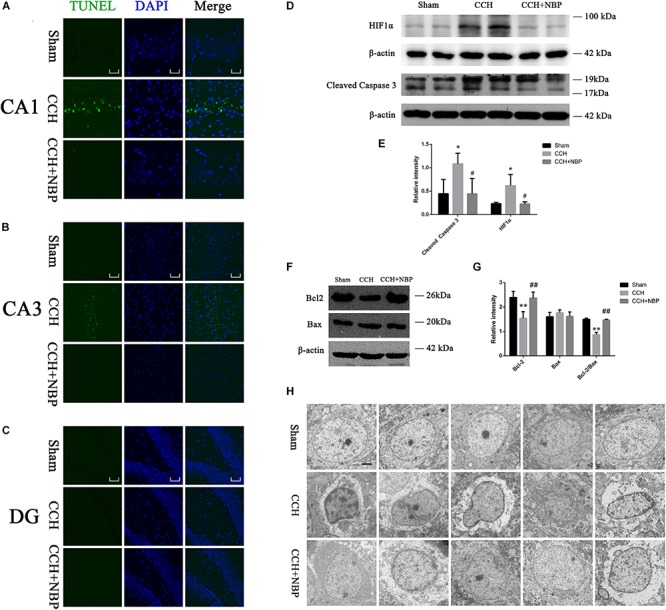
Dl-3-n-butylphthalide improved hippocampal neuronal apoptosis in the CCH model. TUNEL staining (green) shows neuronal apoptosis in the hippocampus (CA1(A), CA3(B), and DG(C) areas) of sham, CCH, and CCH + NBP groups at 8 weeks after BCCAO. Nuclei were stained with DAPI (blue). CA1 area, 400× magnification, scale bar = 25 μm. CA3 and DG areas, 200× magnification, scale bar = 50 μm. (D) Western blot analysis of the expression of HIF-1α and cleaved caspase-3 in vivo. (E) The expression of HIF-1α and cleaved caspase-3 were quantified and represented as a histogram. β-actin was used as an internal control. n = 3 experiments. *P < 0.05, CCH group vs. sham group; #P < 0.05, CCH vs. CCH + NBP group. (F) Bcl-2 family proteins are involved in the anti-apoptotic effect of NBP. (G) The expression of Bcl-2, Bax and Bcl-2/Bax ratio were quantified and represented as a histogram. β-actin was used as an internal control. n = 3 experiments. ∗∗P < 0.01, CCH group vs. sham group; ##P < 0.01, CCH vs. CCH + NBP group. (H) NBP treatment protects against morphological and ultrastructural changes of neurons in the hippocampus. Sham group: the neurons in the cortex had large round nuclei, the double nuclear membranes were clear and complete. CCH group: neurons were irregular and exhibited chromatin condensation, cytoplasm dissolution, and vacuole formation. The nuclear membranes and organelles of neurons were dissolved or absent. NBP treatment group: the damage to the neurons was alleviated (n = 5 per group). Scale bar = 2 μm. CCH: CCH 8w; CCH + NBP: CCH 8w + NBP.